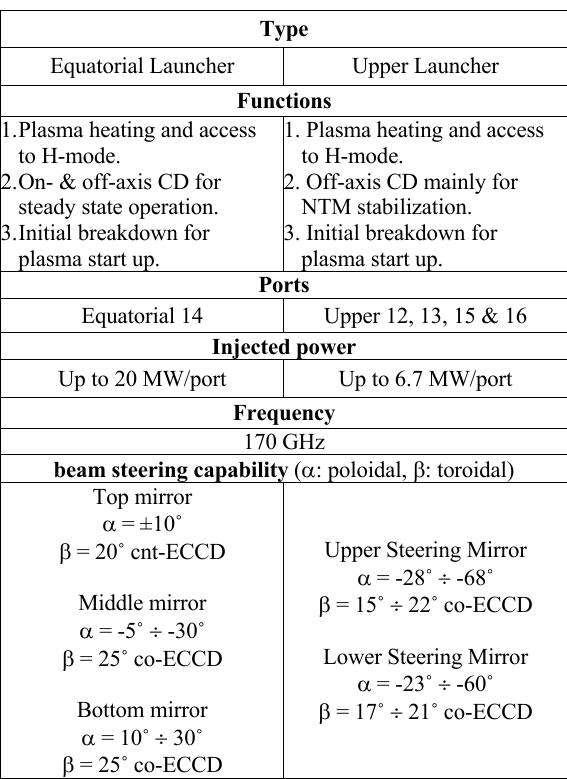
Table 1. Summary of launcher design